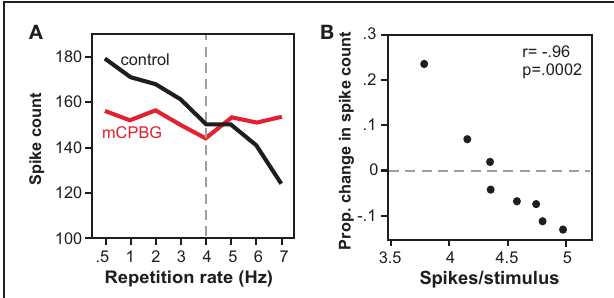
FIGURE 6 | Effects of the 5-HT3 receptor vary with stimulus repetition rate and spike rate. (A) Spike counts decrease with repetition rate in the control, but not during iontophoresis of a 5-HT3 agonist (mCPBG) for a single IC neuron. Stimulus consisted of a 20ms tone at 13kHz. (B) The same data as in (A) is plotted as a function of mCPBG-evoked change in spike count versus control spike rate. The 5-HT3 agonist increases spike count at low spike rates, and decreases spike count at high spike rates. All panels were reprinted with permission from Elsevier; additional information on the source article can be found in the